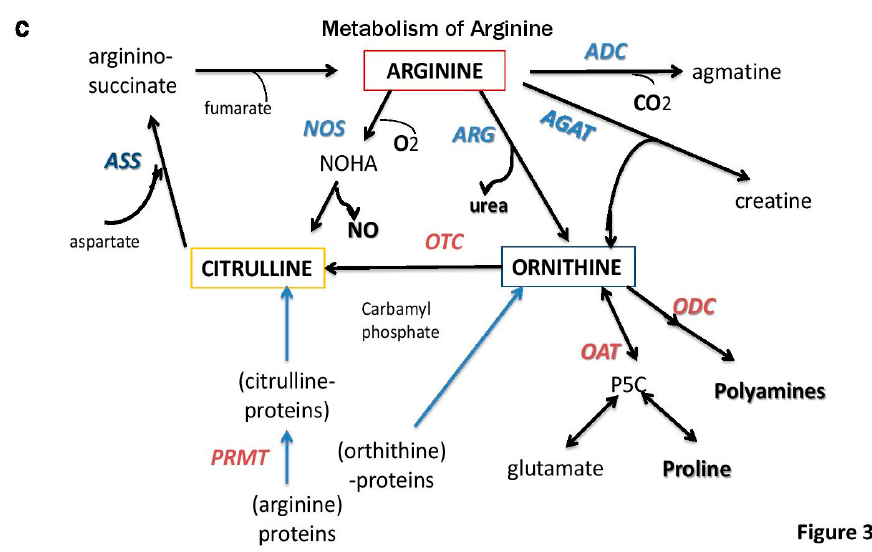
Figure 3. Bioenergetics of macrophage subsets. Monocyte-derived macrophages can be differentially polarized by the cytokine milieu [125,126]. ( A ) M1 macrophages originate from cells in the bone marrow and develop in inflammatory environments. Nitric oxide (NO) is the major byproduct of these cells arising from the reaction of arginine with oxygen through the actions of inducible nitric oxide synthase (iNOS) which produces citrulline and NO (see detailed pathway Figure 3C). Citrulline is then exported and re-imported to re-generate arginine and sustain NO production. A product of the degradation of arginine through this cycle is fumarate which is derived from the conversion of argininosuccinate to arginine (see Figure 3C). M1 macrophages are also critical for the production of cytokines and chemokines and for the production of itaconate which acts as an anti-microbial cellular metabolite. Succinate, a proinflammatory molecule that controls IL-1 β expression, accumulates and stabilizes the oxygen sensing pathway regulated by hyposia-inducible factor 1-alpha (HIF1 α ) [125,127]. ( B ) Unlike M1 macrophages, the polarized M2 subtype reduces their ability to make NO and instead hydrolyzes imported arginine into ornithine and urea through the urea cycle (detailes in Figure 3C). M2 macrophages are therefore suppressive by competing for both arginine and glutamine that is necessary for effector T-cell functions [63,89,112]. To fuel their functions, including proliferation, M2 macrophages use fatty acids oxidation (FAO) which supports oxidative phosphorylation and electron transport through the tricarboxylic acid (TCA) cycle. Also present in the suppressive tumor microenvironment is a population of bone marrow derived immature myeloid cells known as myeloid derived suppressor cells [128,129]. While bioenergetics for these cells needs further analysis, they retain NO production and FAO, TCA and deplete arginine and glutamine [130] from the microenvironment. ( C ) Also detailed is the metabolism of arginine, L -citrulline and L -ornithine to produce fumarate from conversion of argininosuccinate. Citrulline plus aspartate generates argininosuccinate via the actions of argininosuccinate synthetase (ASS) in the cytosol and ornithine is converted to citrulline by carbamylphosphate plus ornithine via the enzymatic activity of ornithine transcarbamoylase (OTC). Additional enzymes and reactions include those metabolized by ODC: ornithinine decarboxylase, ARG: arginase 1 or arginase 2, ADC: arginine decarboxylase which is the biosynthetic enzyme for agmatate [131], OAT: ornithine aminotransferase, NOS: nitric oxide synthase, PRMT: protein arginine methyltransferases which is important for epigenetic regulation [132], and AGAT: L -arginine:glycine amidinotransferase which is the enzyme that catalyzes the transfer of an amidino group from L -arginine to produce L -ornithine and guanidinoacetate and acts as the immediate precursor of creatine.